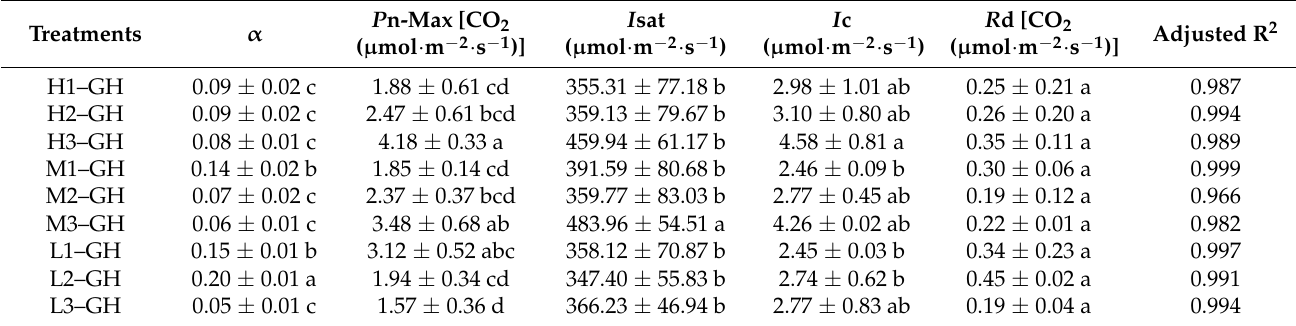
Table 1. Photosynthetic parameters of the leaves under different light conditions in the greenhouse.